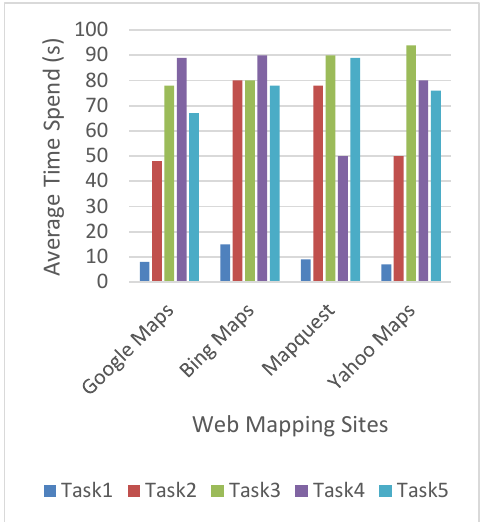
Figure1 Different Web Mapping Sites based on average time spend for each task in the experiment